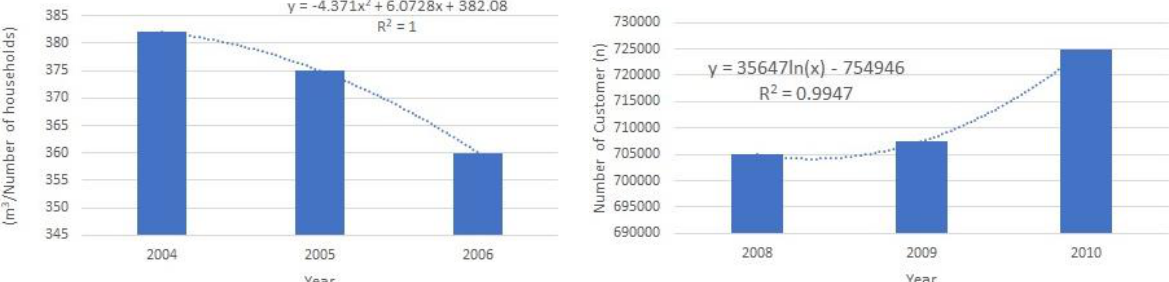
Fig. 6. Number of customers of piped-water before the implementation of progressive tariffs in Jakarta